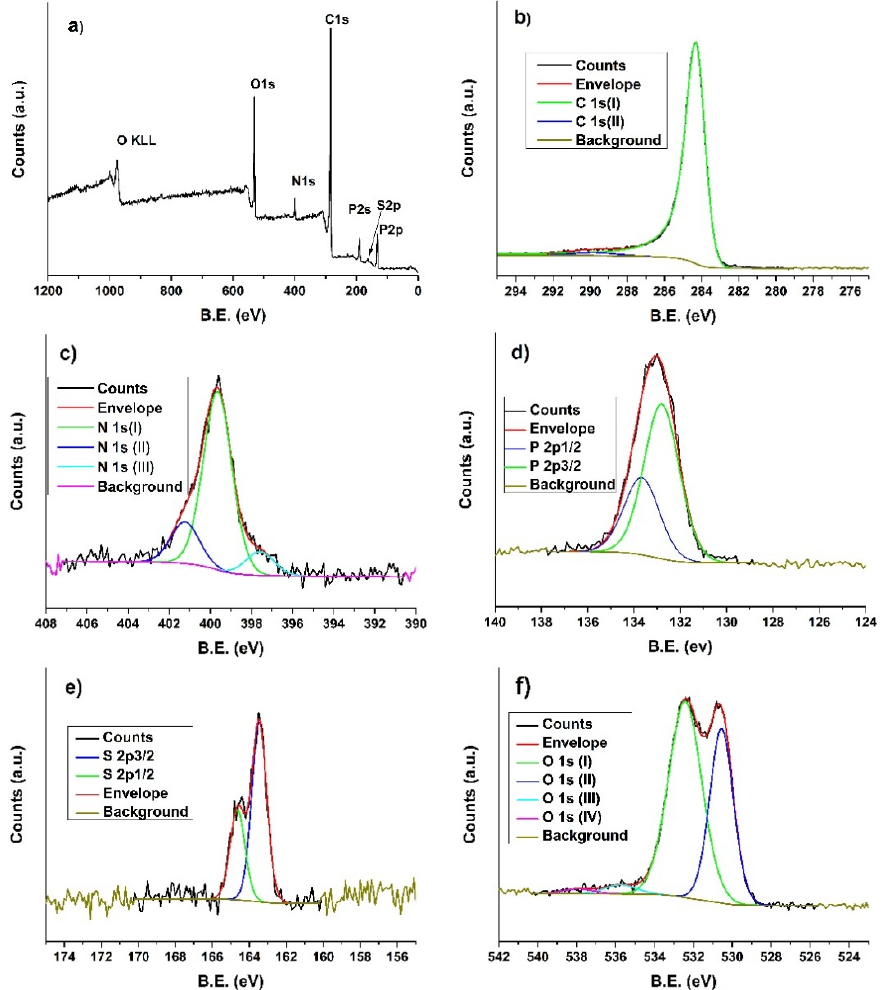
Figure 4. XPS of the CNSs sample: ( a ) survey spectrum and fitted high resolution spectra of; ( b ) C 1 s ; ( c ) N 1 s ; ( d ) P 2 p ; ( e ) S 2 p ; and ( f ) O 1 s .